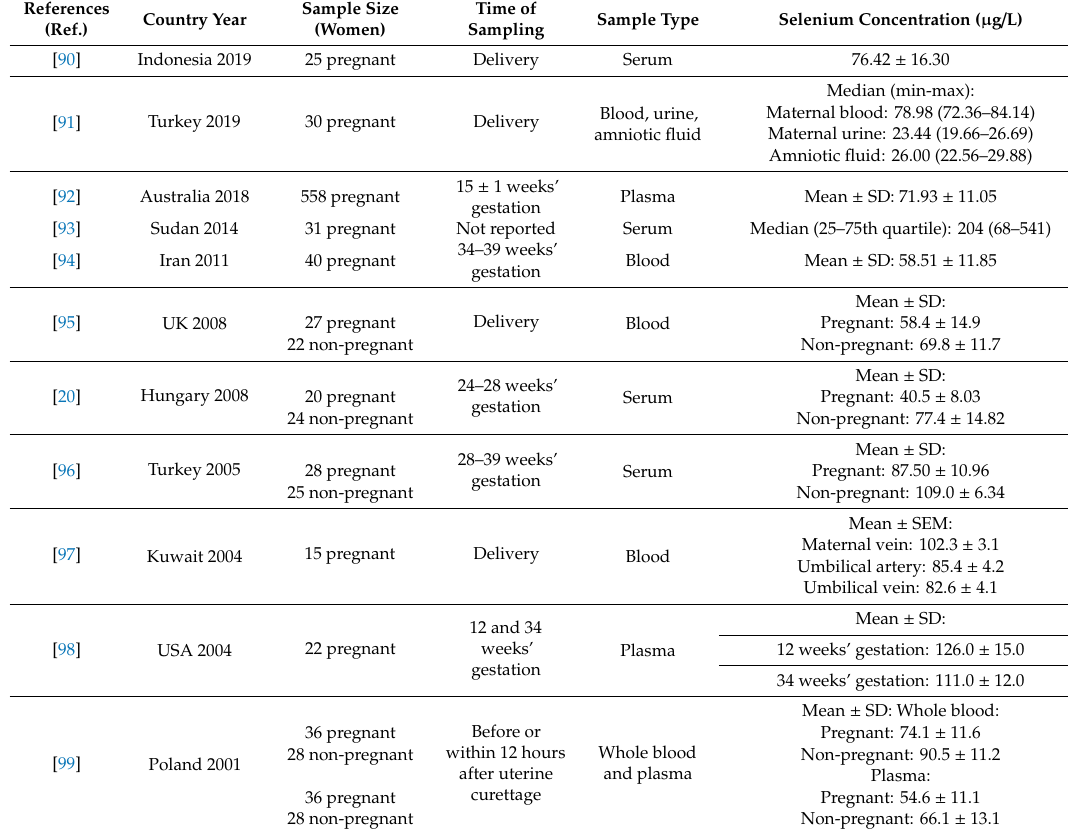
Table 1. Selenium levels in women of reproductive